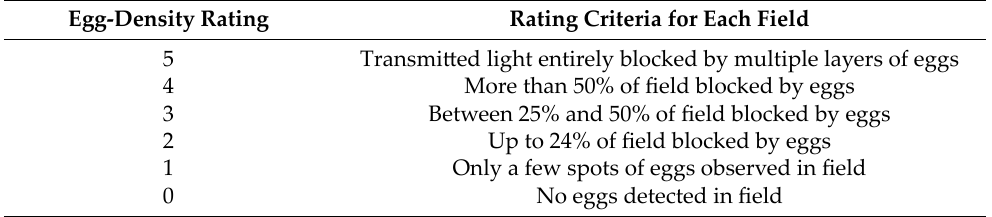
Table 3. Protocol and criteria used to determine egg‑density ratings for Huffmanela infection levels in centrarchid swimbladders. Egg‑Density Rating Rating Criteria for Each